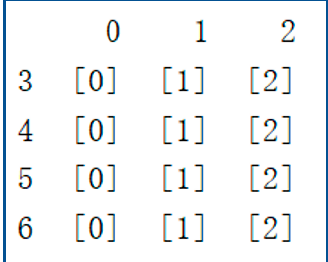
Figure 5. Upper half (running result of Python).